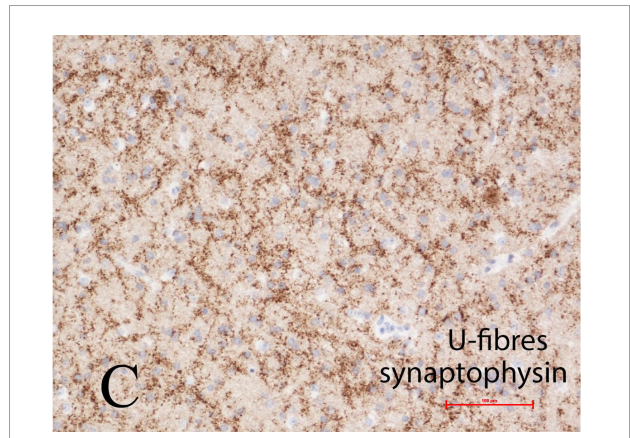
FIGURE5 Complex synaptic plexi are formed between heterotopic neurons in the U-fiber layer beneath the cortex in normal brain but are greatly increased beneath focal cortical dysplasias (FCD) types I or II, as here demonstrated with synaptophysin immunoreactivity at the base of a gyrus in a 4-year-old girl with FCD type IIa. These plexi also integrate with overlying cortex and thus may contribute to epileptic networks. Reproduced from reference (Sarnat et al.,